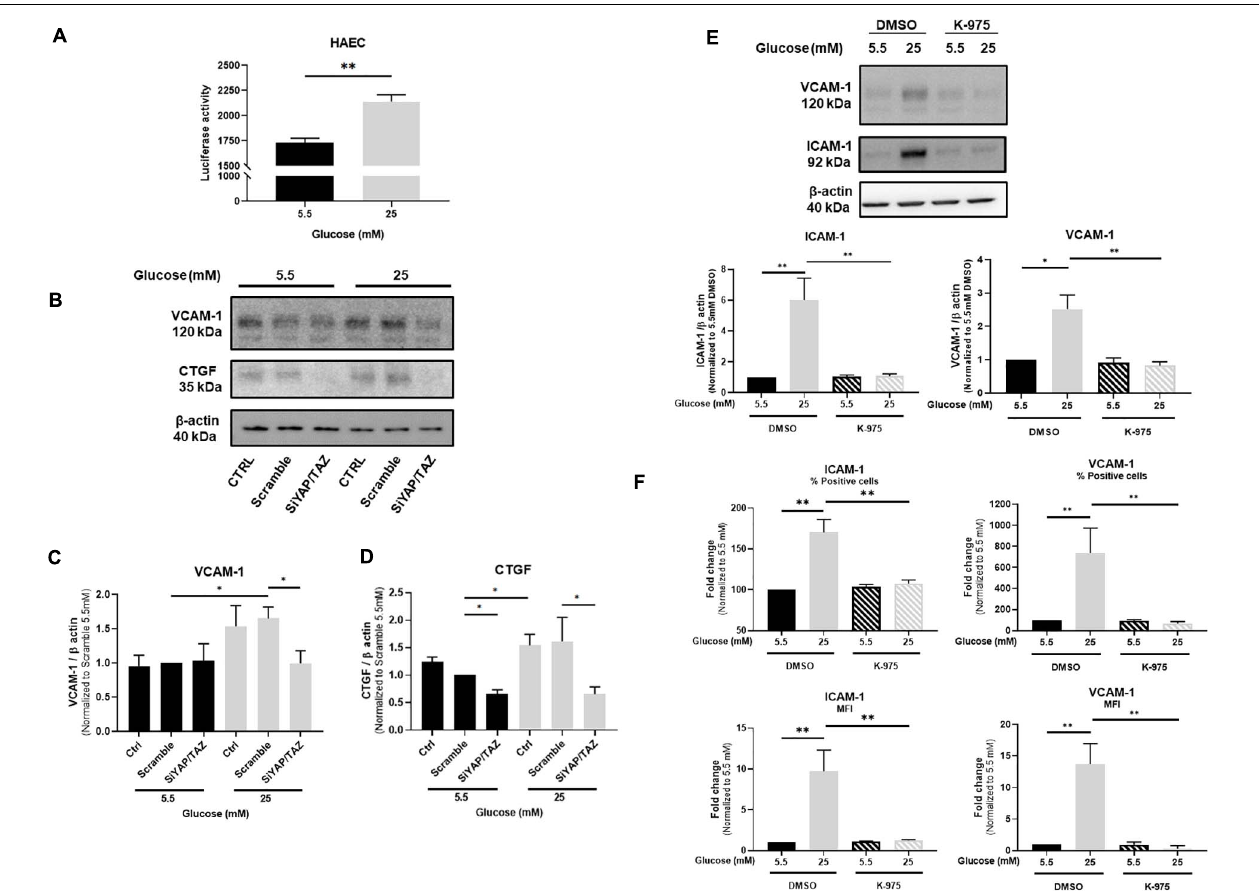
FIGURE 2 | YAP mediates glucose-induced endothelial activation. Activity of TEAD-luciferase in TeloHAECs cultured under either normal or high glucose (A) . Representative protein expression blots (B) and bar graphs showing the expression of VCAM-1 (C) and CTGF (D) in HUVECs cultured under static conditions with either normal or high glucose and additionally treated with siRNA for YAP/TAZ. Representative protein expression blots and bar graphs showing the expression of VCAM-1 and ICAM-1 (E) as well as their percentage (%) and cell surface expression (represented as mean of fluorescence – MFI) assessed by flow cytometry (F) in HUVECs cultured under static conditions with either normal or high glucose for 24 h and in the presence, or not, of the YAP/TEAD inhibitor K-975 at 200 nM. DMSO was used as control. Data are presented as the mean ± SEM. N = 3/group for panel A; N = 4/group for panel C; N = 6/group for panel D; N = 6–7/group for panel E; N = 5/group for panel F. ∗ p < 0.05 and ∗∗ p < 0.01 between the indicated groups. Two-tailed Mann-Whitney test was used for comparisons between the